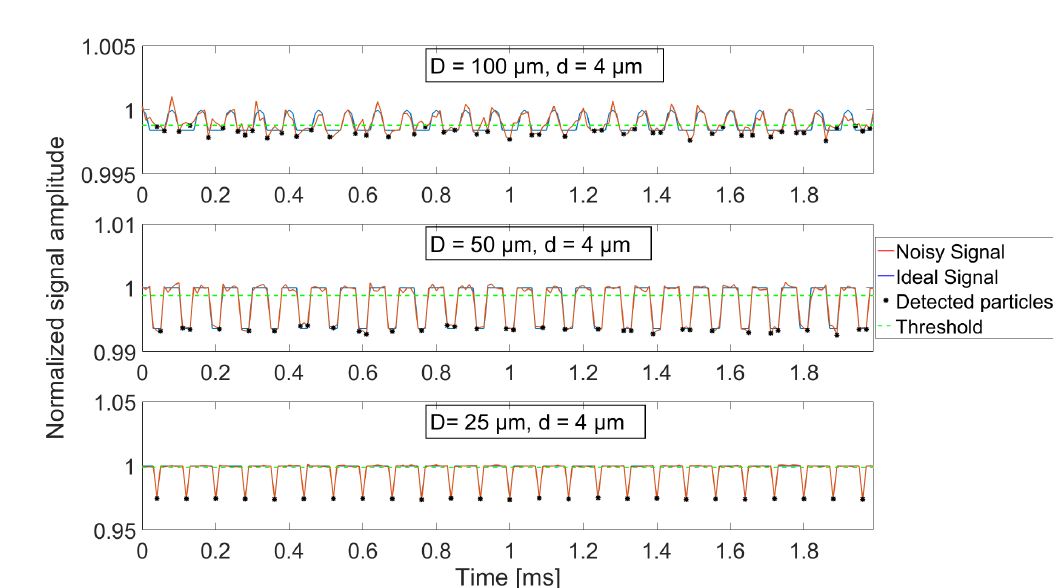
Figure 14. 2ms signal sequences of both ideal (blue) and noisy (red) signal outputs, for aperture diameters of 100µm (upper), 50µm (middle) and 25µm (lower) where 4µm diameter particles are simulated and a medium noise level ( σ 2 ) has been added to construct the noisy signal. Samples below the 3 σ threshold (green dashed line) where the algorithm has detected a particle are highlighted with black